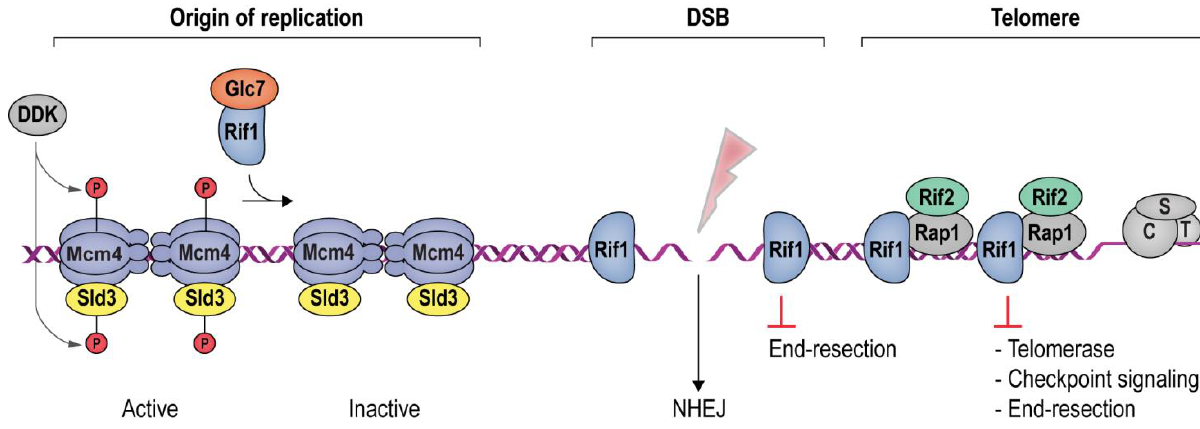
FIGURE 1: Rif1 is a multi-faceted genome maintenance factor. At origins of replication, Rif1 attenuates origin firing by recruiting PP1/Glc7, which reverses activating Mcm4 and Sld3 phosphorylation mediated by DDK (see Box 1 ). At DSBs, Rif1 tightly encases the break ends, gating access of the end-resection machinery. As a result, DSB ends are stabilized, promoting their re-ligation by NHEJ. At budding yeast telomeres, Rif1 forms part of an interlinked telosome protein meshwork with Rap1 and Rif2, underpinning telomere architecture and func- tion. In addition, direct Rif1-DNA interactions are required to counteract telomerase and inadvertent checkpoint activation at chromo- some ends (see text for details). CST denotes the Cdc13-Stn1-Ten1 complex bound to ssDNA telomeric